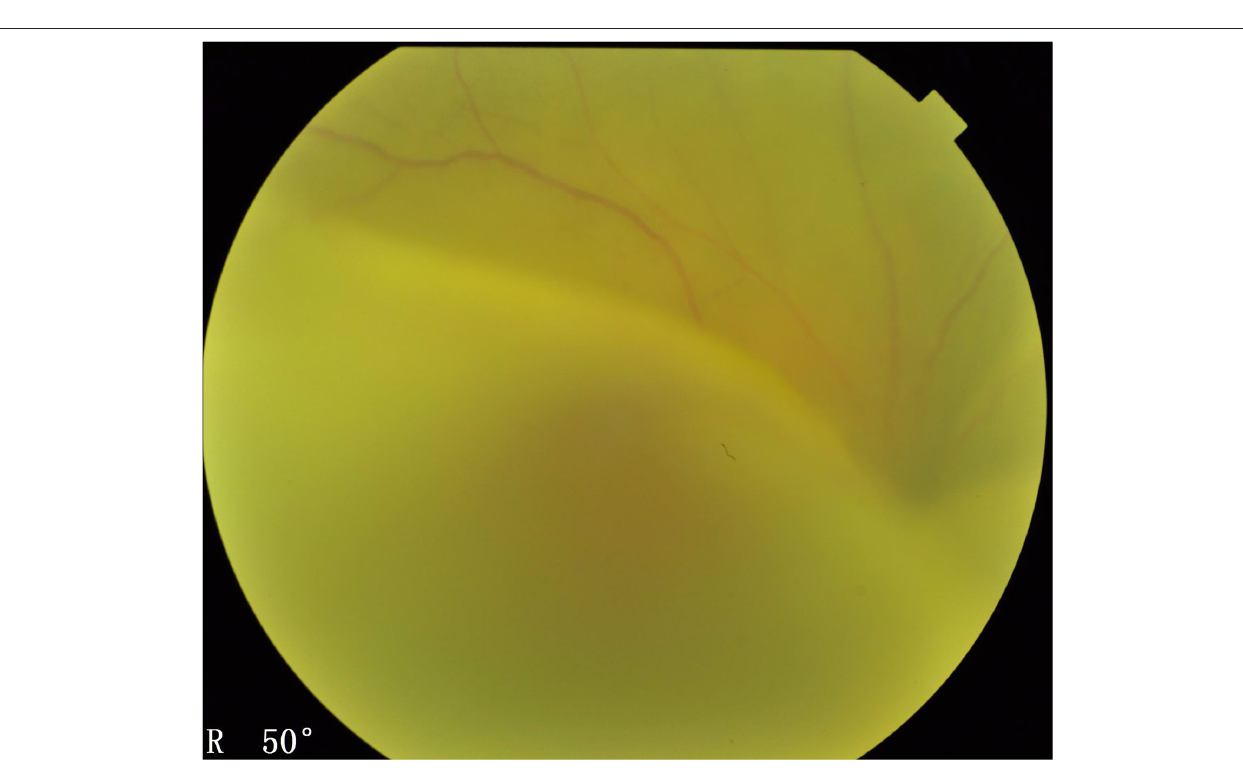
OCT and OCTA The choroidal thickness and macular areas in both eyes of UES patients were evaluated via OCT and OCTA. All eyes (type 1 and type 2) showed